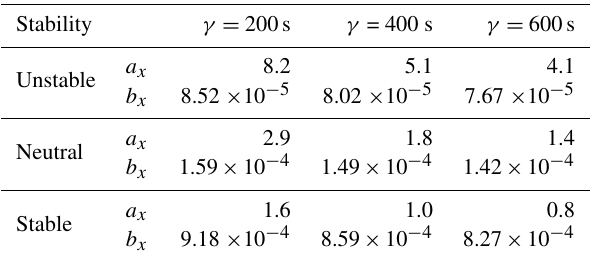
Table 2. The fitted parameters for the exponential longitudinal co- herence model.